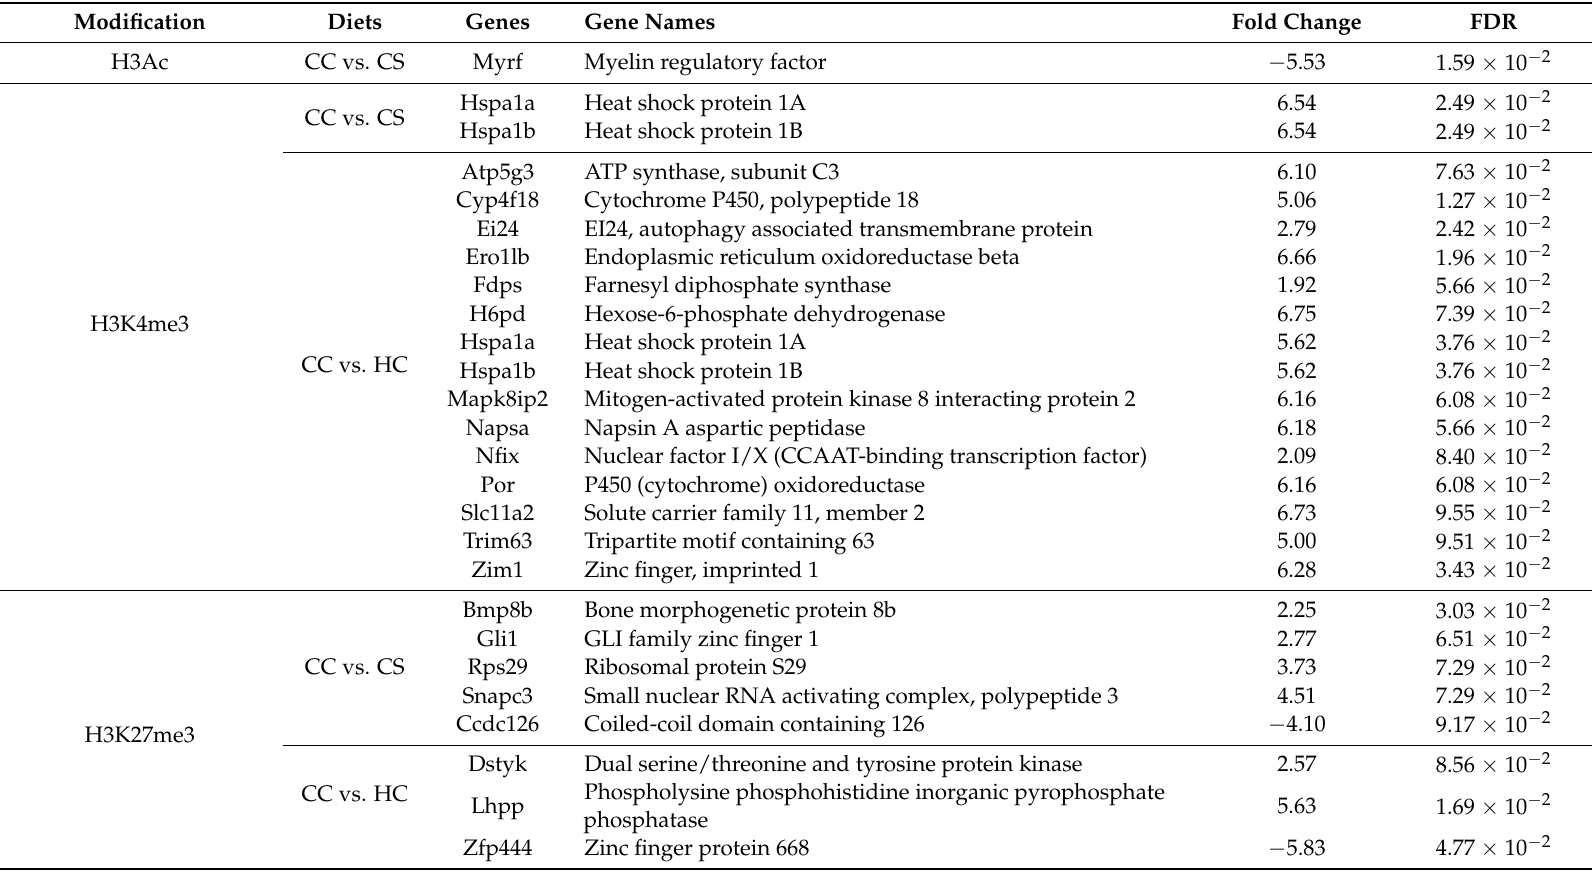
Table 2. Genes corresponding to differentially bound histone peaks and with functional relevance to ‘metabolic